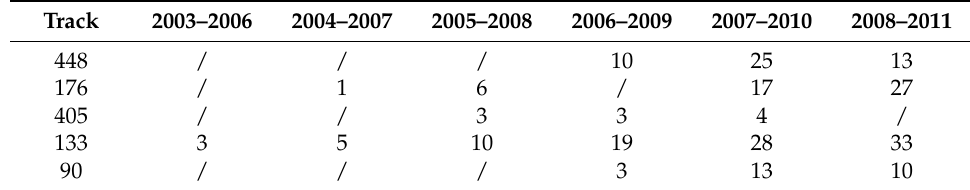
Table 2. Number of the interferograms on five descending tracks used in each sub-period to derive the temporal evolution of the postseismic